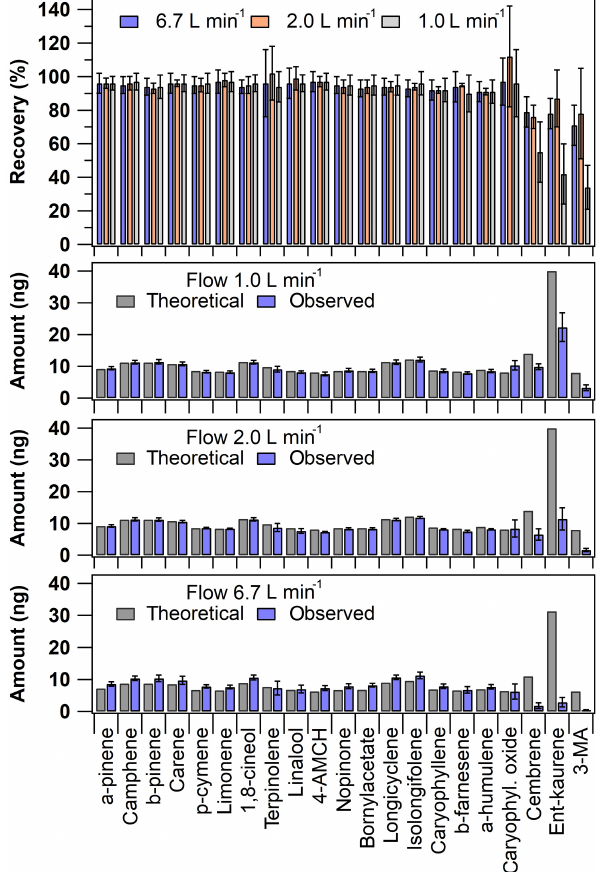
Figure 3. Cuvette recovery results (top panel) and the absolute amount detected in the first sampling sorbent tube presented ac- cording to the different inlet flow rates used (the lowest three pan- els). The theoretical expected amount was calculated based on the used experimental conditions. The error bars represent reproducibil- ity ( n =